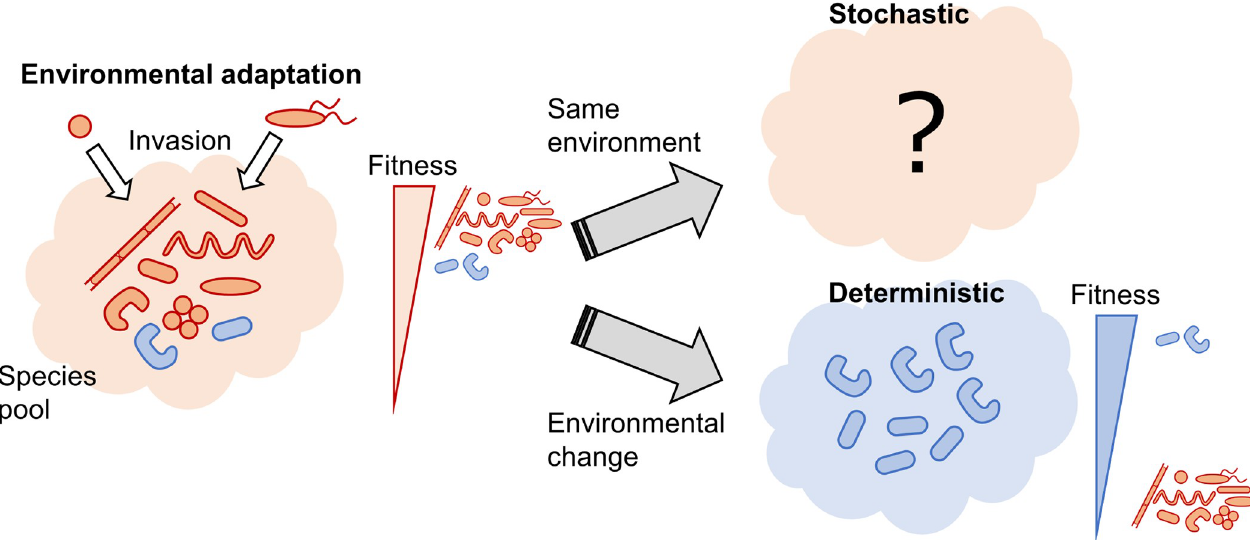
Fig 1. Schematic of a rule proposing deterministic assembly by environmental change. If the environment changes from its original state that fits many pooled microorganisms, the assembly of microbial communities may become deterministic due to the limitation of possible self-organization patterns.